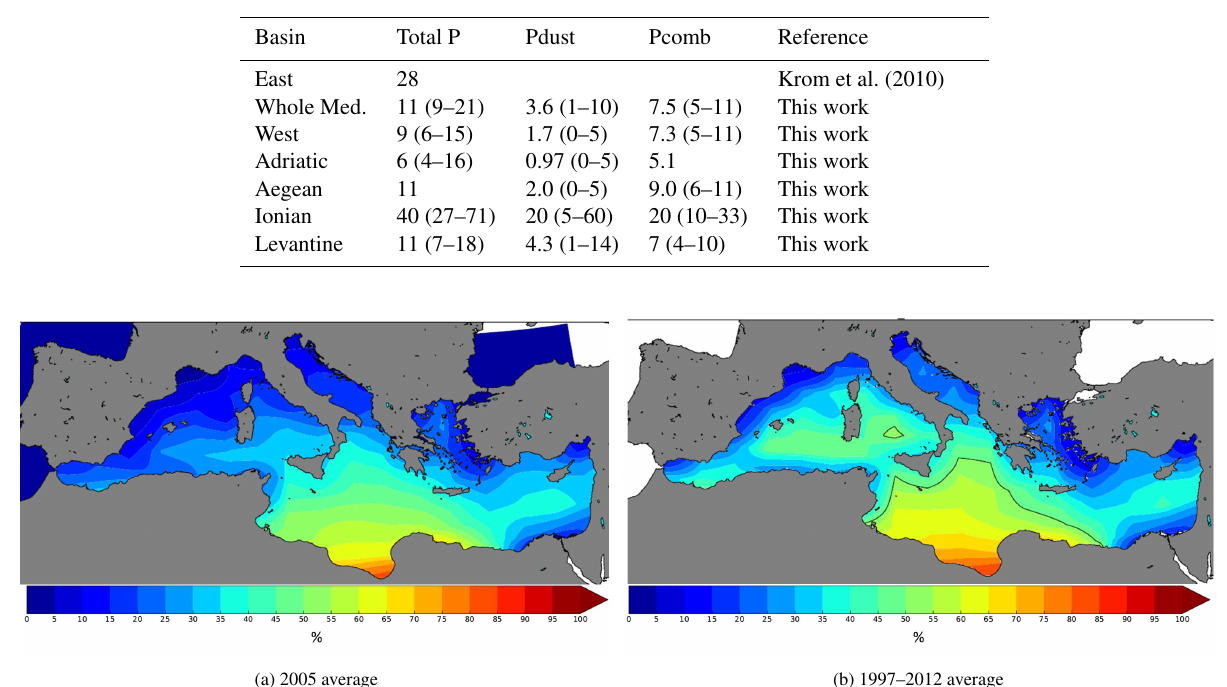
Table 3. Relative atmospheric contribution (%) to total PO 4 supply in different sub-basins (atmospheric inputs/(atmospheric in- puts + riverine inputs + Gibraltar inputs)) according to the model. The values in parentheses show the minimum and maximum monthly contributions over the year when variability is more than 3%. The sub-basins are described in Fig. 5. Values from Krom et al. (2010) also include river inputs.